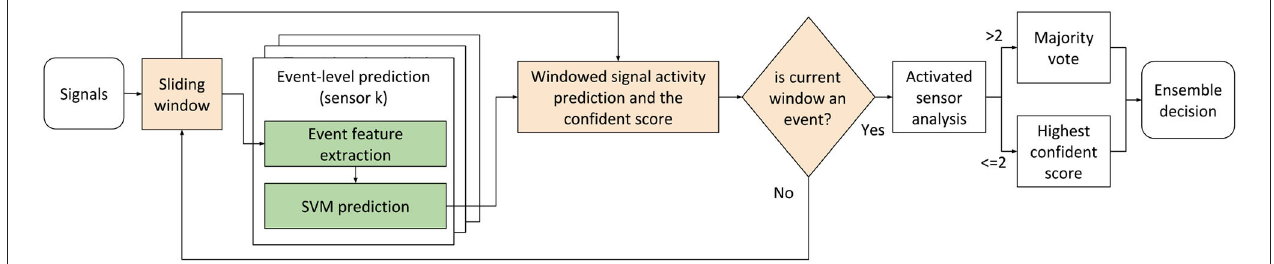
FIGURE 6 | Ensemble algorithm.